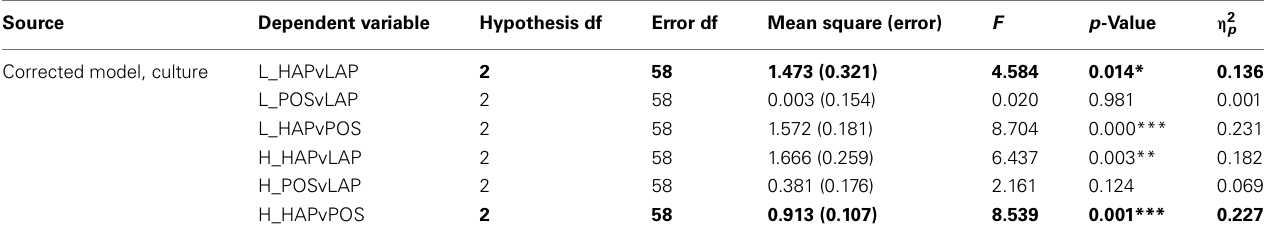
TableA12 | Univariate tests of simple effects of categorization difference scores from ipsatized